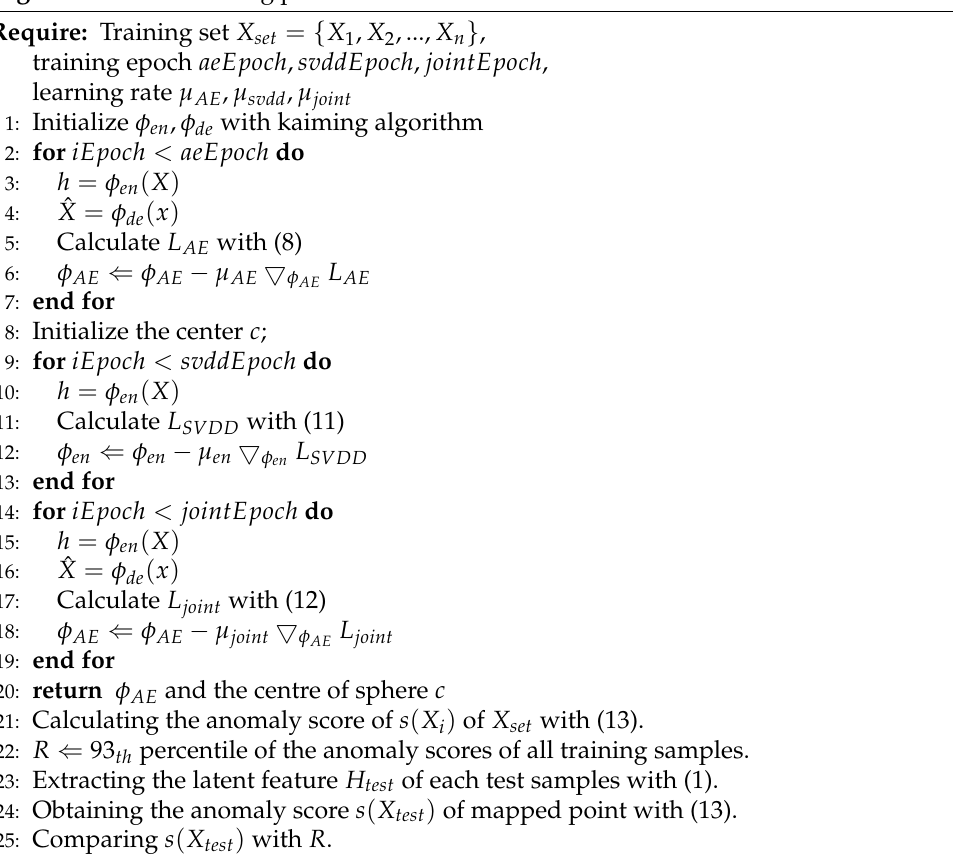
Algorithm 1 The working procedure of